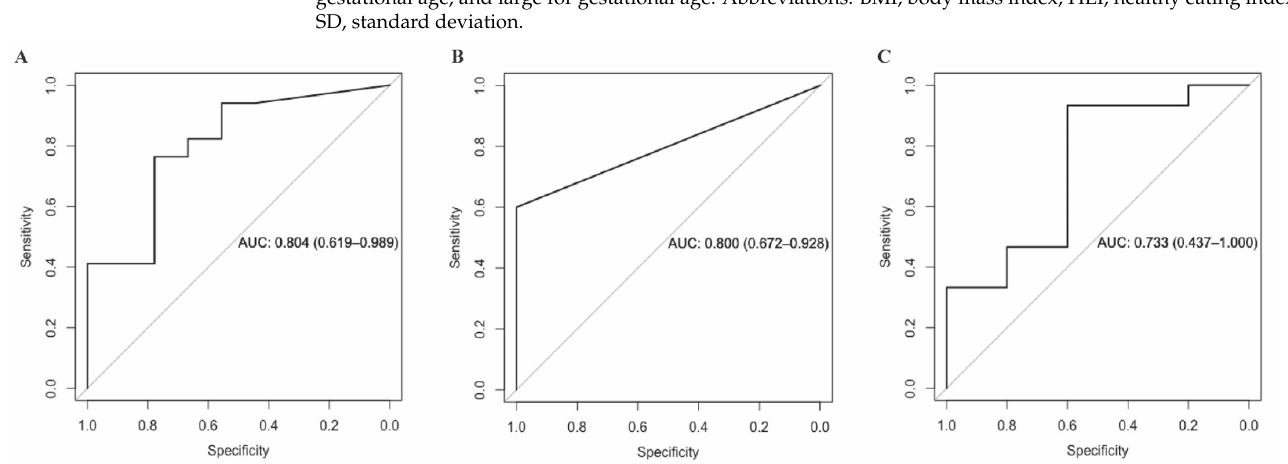
Figure 1. Receiver operating characteristic curves for panels of metabolites to predict excessive gestational weight gain. ( A ) Twelve metabolites at baseline around 12 weeks of gestation jointly associated with gestational weight gain ( B ) Four metabolites at 32 weeks of gestation jointly associated with gestational weight gain ( C ) Three changes of metabolites from baseline to 32 weeks of gestation jointly associated with gestational weight gain. Participants were randomly divided into training and validation sets with a ratio of 1:2, based on which the area under the curve (AUC) was calculated using logistic regression models.